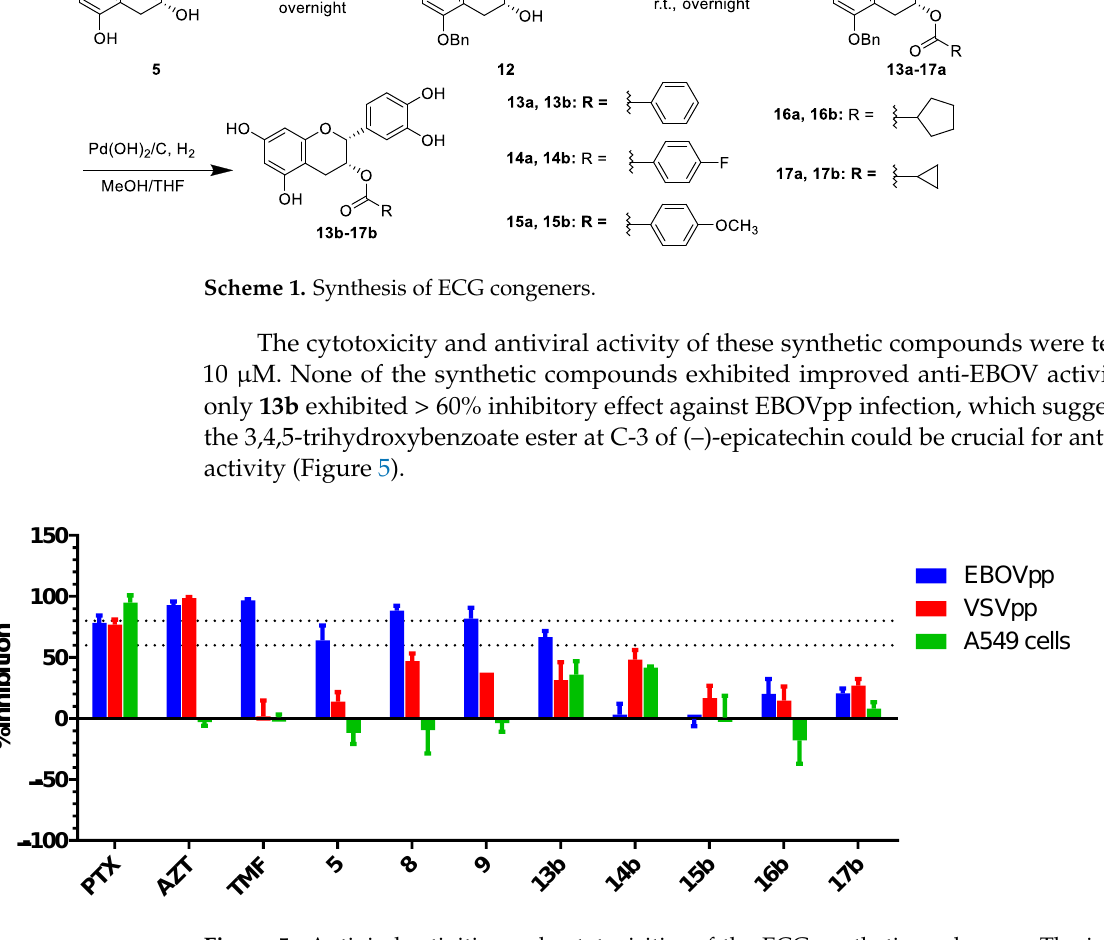
Figure 5. Antiviral activities and cytotoxicities of the ECG synthetic analogues. The inhibitory effects of samples against EBOVpp, VSVpp, and A549 cells were tested at 10 µM for the polyphenol compounds, 23.4 nM for PTX (paclitaxel), 74.9 nM for AZT (azidothymidine), and 1.23 µ M for TMF (toremifene). Data are means ± SD ( n = 3) from three independent